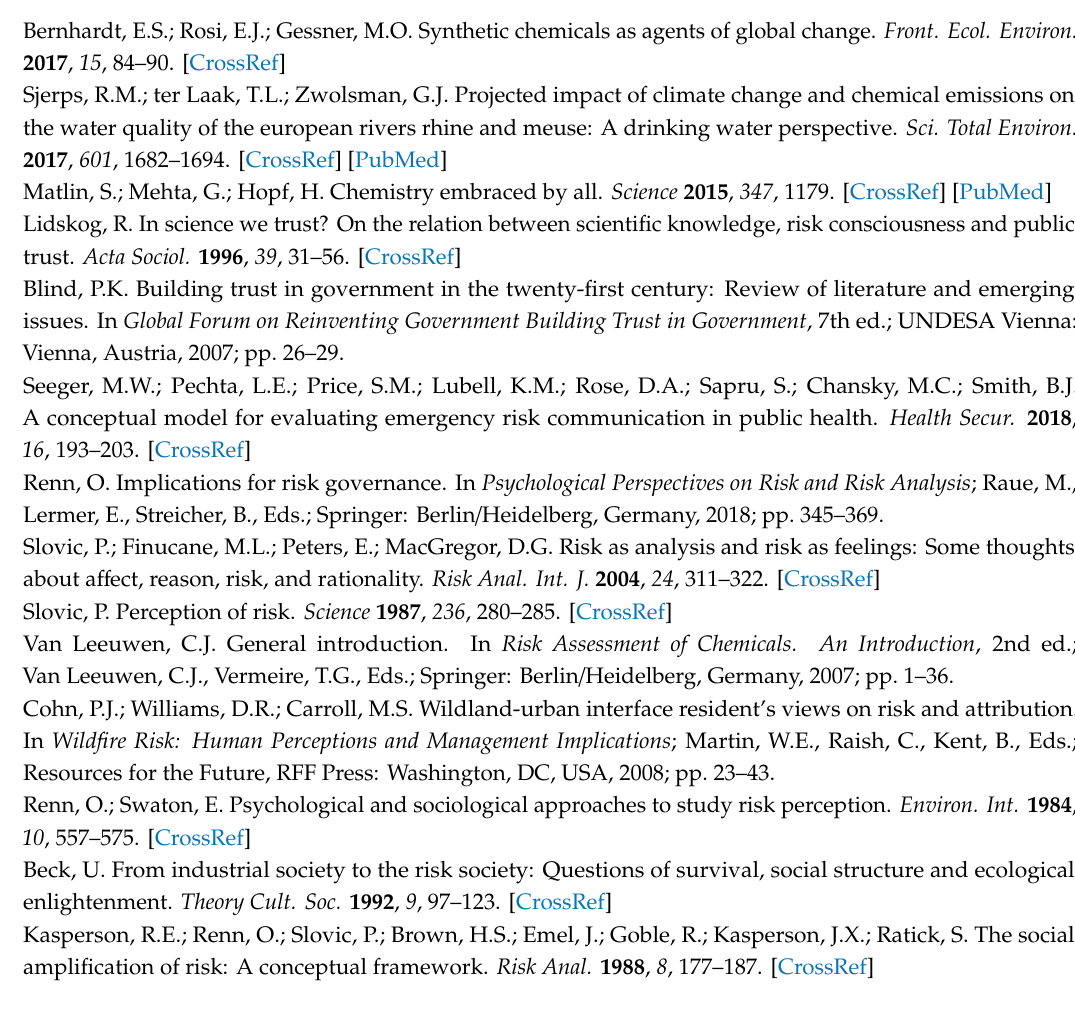
Table S1: Test results between customer characteristics and the degree of concern about quality and safety; Table S2: Test results between customer characteristics and the opinion that tap water containing very small amounts of non-natural substances is safe to drink as long as the amount falls within the legal